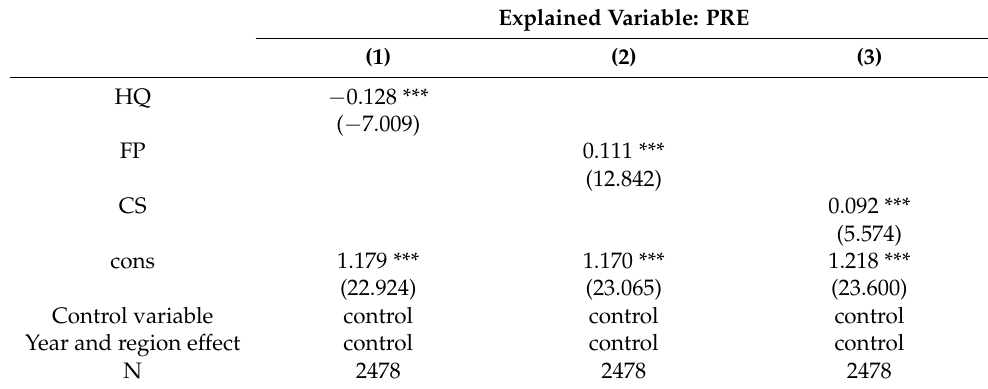
Table 5. National PRE and ecological service value: sub-dimensions analysis.